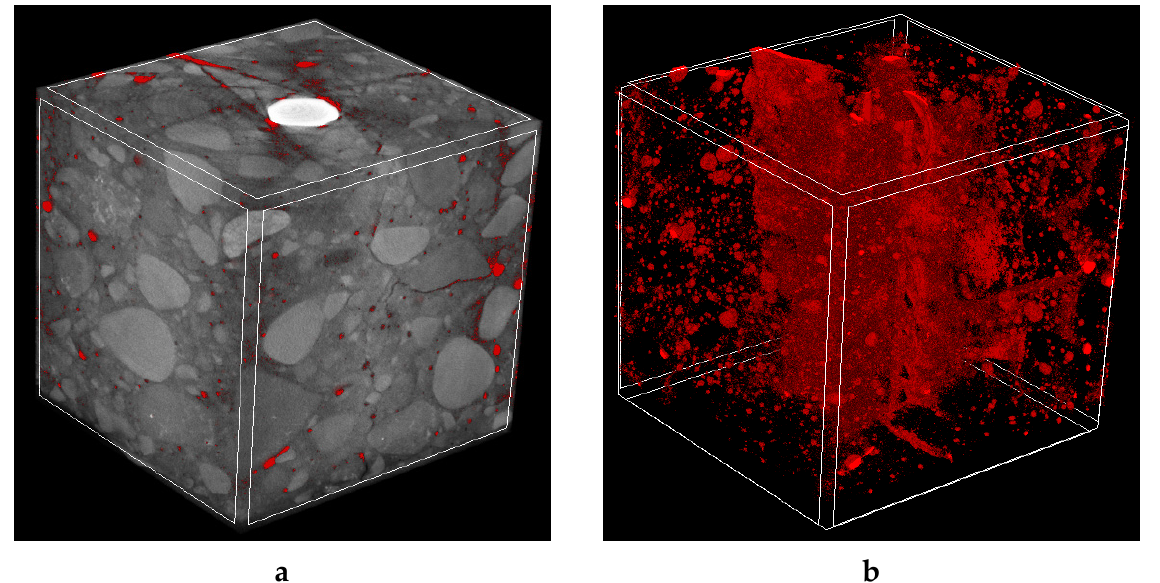
Figure 10. The 3D micro-CT images of cracked concrete cubes reinforced with steel bar after the pull-out test: ( a ) general view with air pores and cracks marked in red and ( b ) separated air pores and cracks.